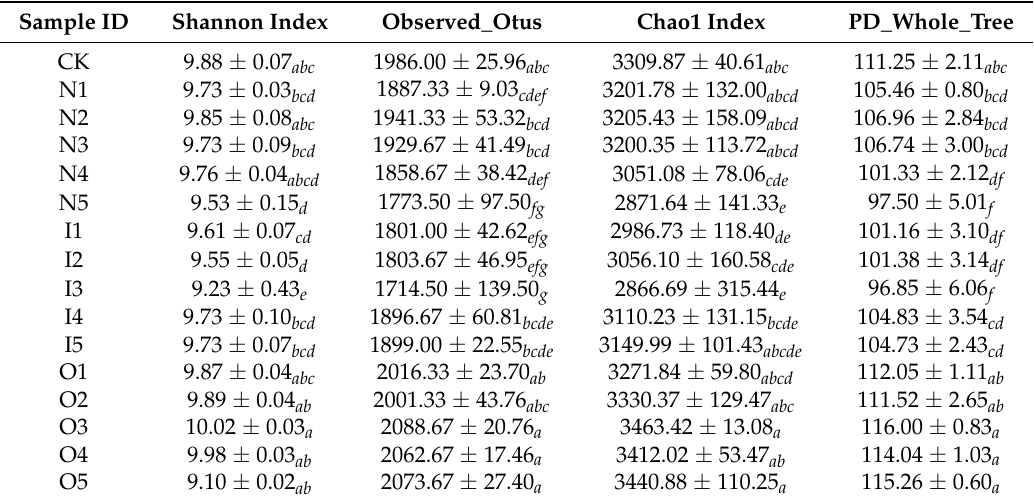
Table 2. Alpha diversity of soil microbial